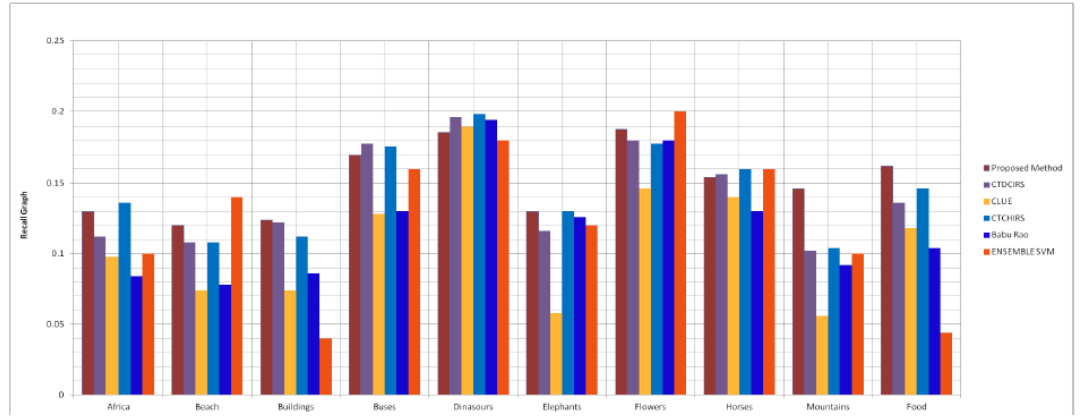
Fig.13. Comparison of average recall obtained by proposed method with other standard retrieval systems [28, 6, 18, 29,